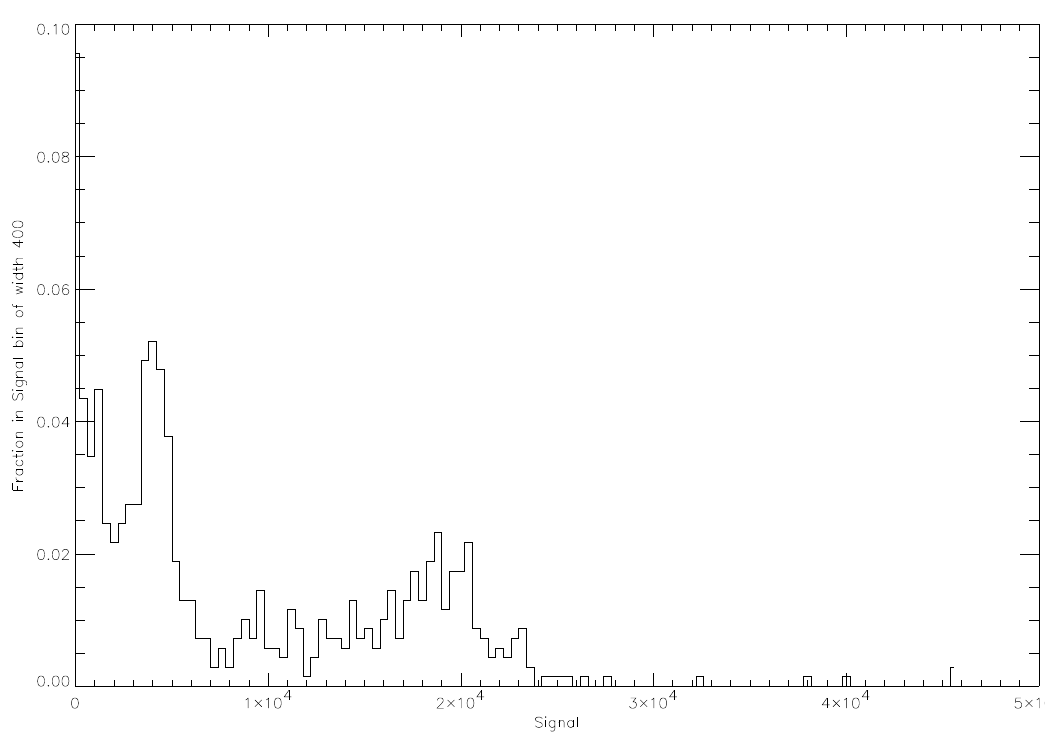
Fig. 5. Integrated lidar returns over 1km by 1km horizontal (14 pulses) and vertical sections, at an attitude of 3km, covering 12000 lidar pulses (equal to approximately 680km along track or 1-h flying time).